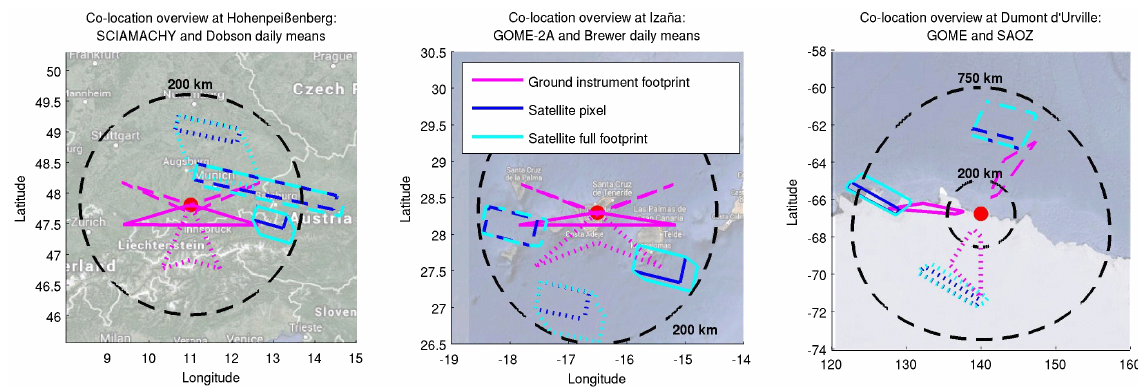
Figure 4. Co-located ground-satellite measurement pairs near summer and winter solstice (dashed and dotted lines, respectively) and near the autumn and spring equinox (solid line). The station is indicated by a red dot, the ground observation operators in magenta, the satellite pixel in dark blue and the full satellite observation operator in